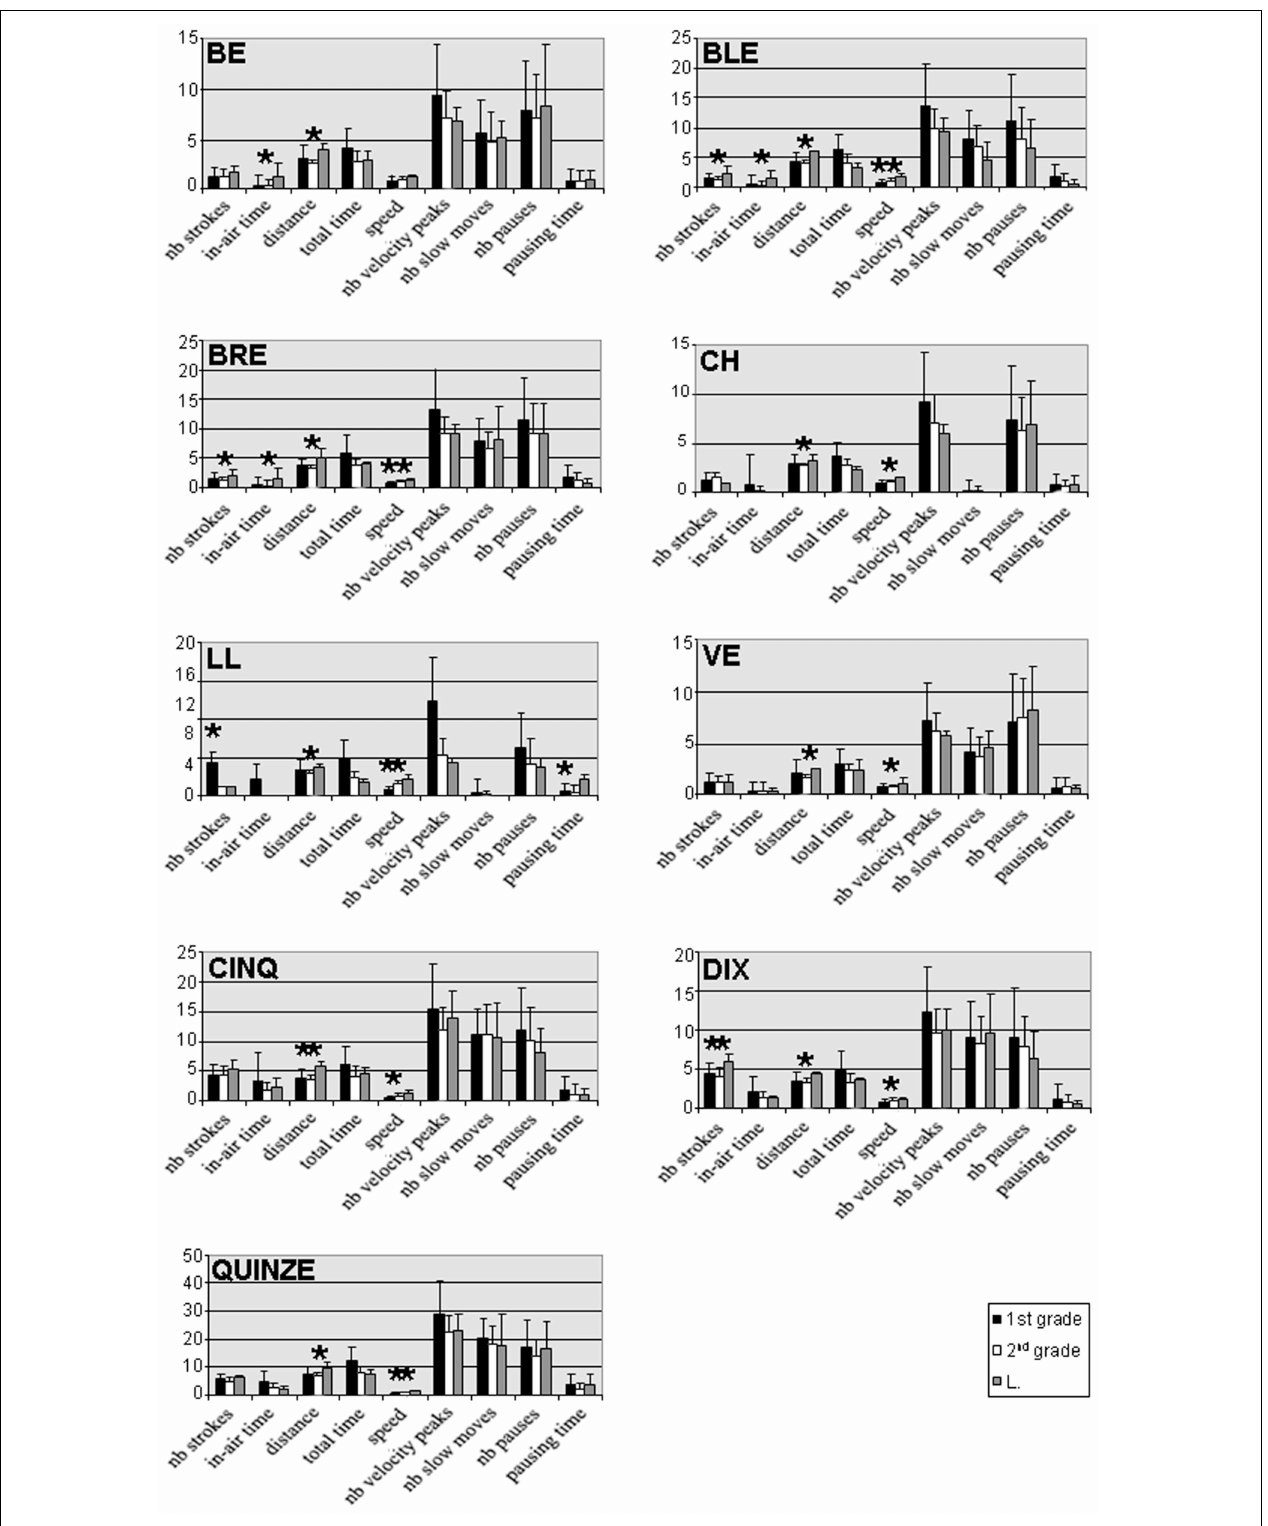
FIGURE 5 | Comparison between the DCD child’s results for syllables and words and those of the 2 control groups. For each parameter and each item, the mean values and SD were calculated for first-graders (black